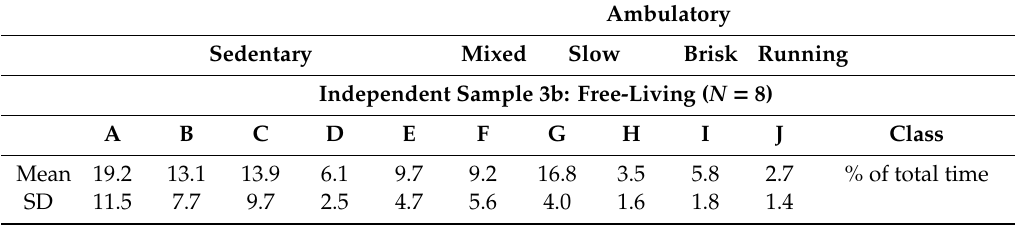
Table 5. Independent dataset 3 (free-living). Percentage of total daily time found in each cluster (A–J). Ambulatory Sedentary Mixed Slow Brisk Running Independent Sample 3b: Free-Living ( N = 8)